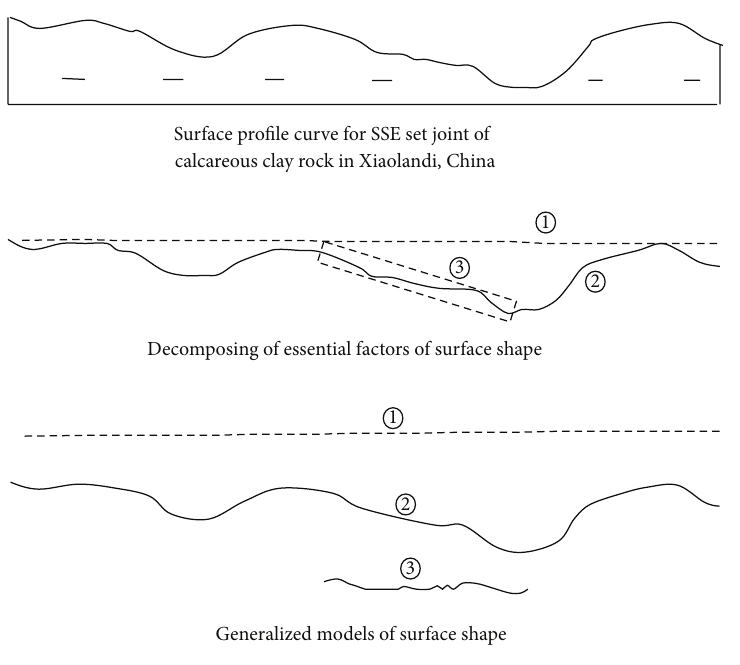
Figure 10: Case study of generalized models of rock joint surface (sample size is 10cm). (1) Macroscopic outline (planar). (2) Surface undulating shape (undulating). (3) Microcosmic roughness